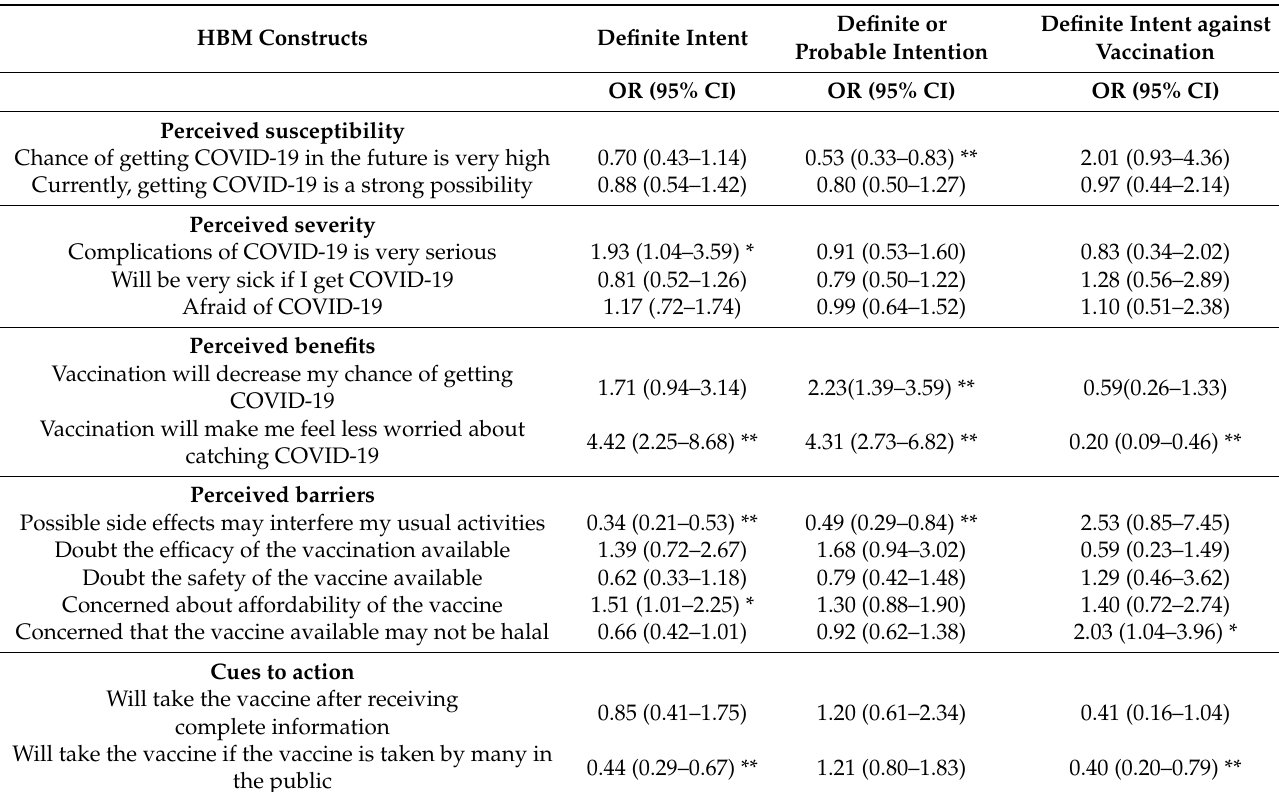
Table 3. Health belief model constructs and SARS-CoV-2 vaccination intent in Bangladesh, multivariable logistic regres- sion